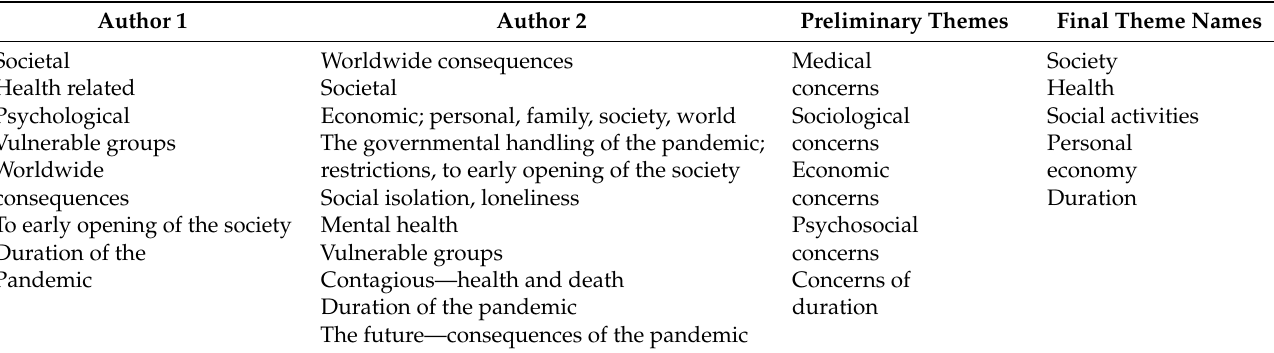
Table 1. Process of developing main